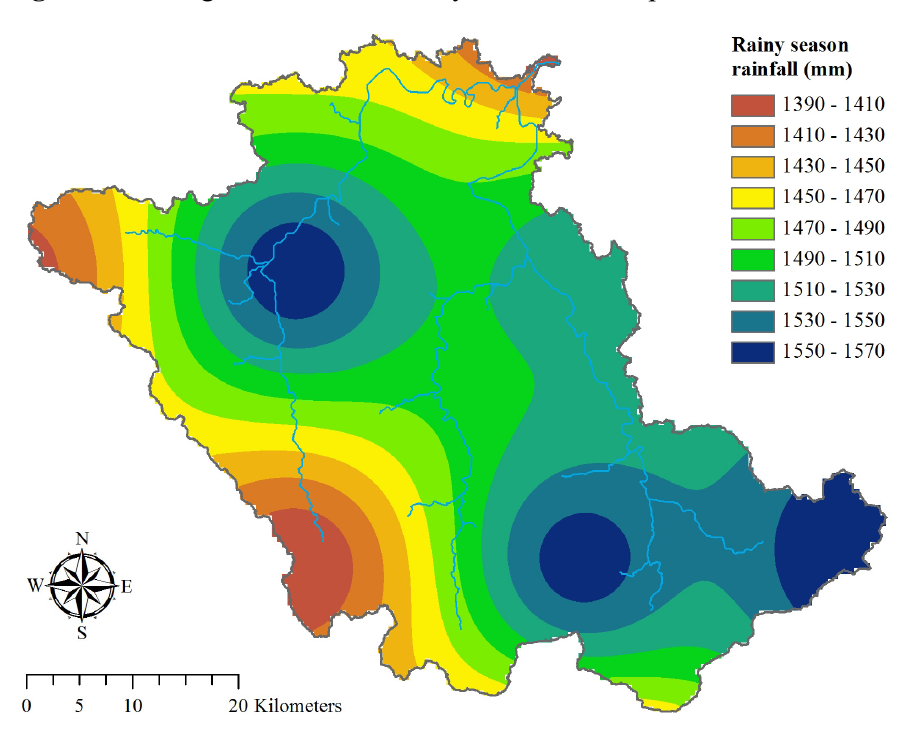
Figure 3. Average rainfall in the rainy season for the period of 2003–2010.